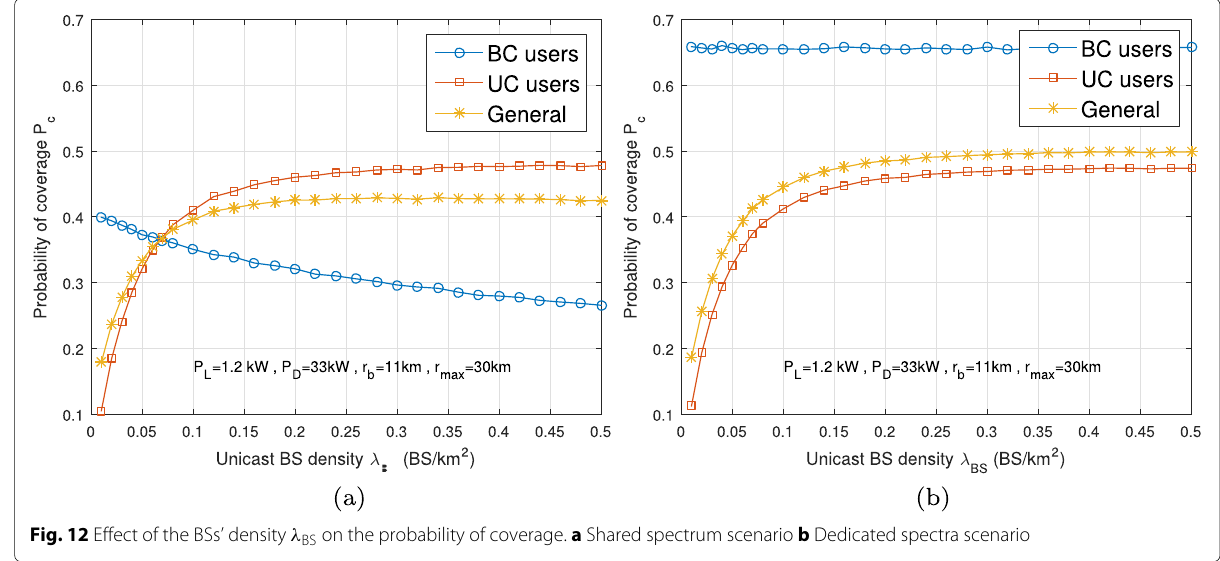
Fig. 12 Effect of the BSs’ density λ BS on the probability of coverage. a Shared spectrum scenario b Dedicated spectra scenario